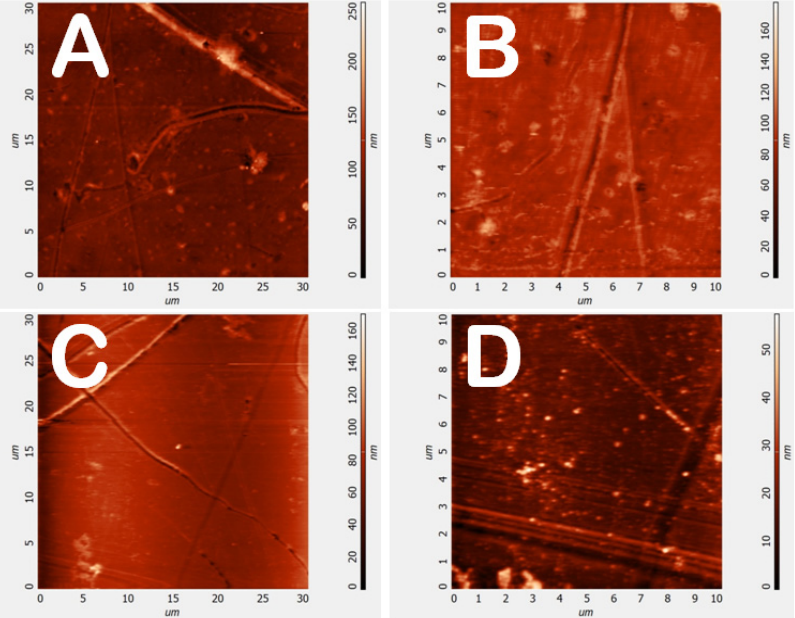
Figure 6. Atomic Force Microscopy (AFM) images of untreated ( A , B ) and plasma treated ( C , D ) PMMA lenses (peak power = 70 W, SF 6 pressure = 30 Pa, DC = 50%).